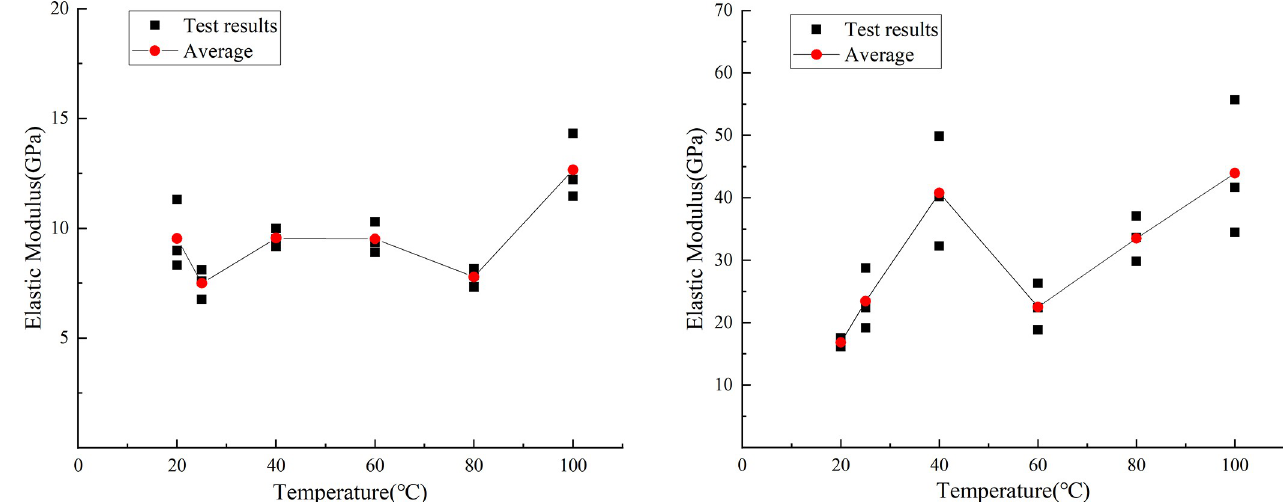
Fig 23. Elastic modulus curve at different temperatures. (a) Elastic moduli responses of rockburst-like materials. (b) Raw rock.